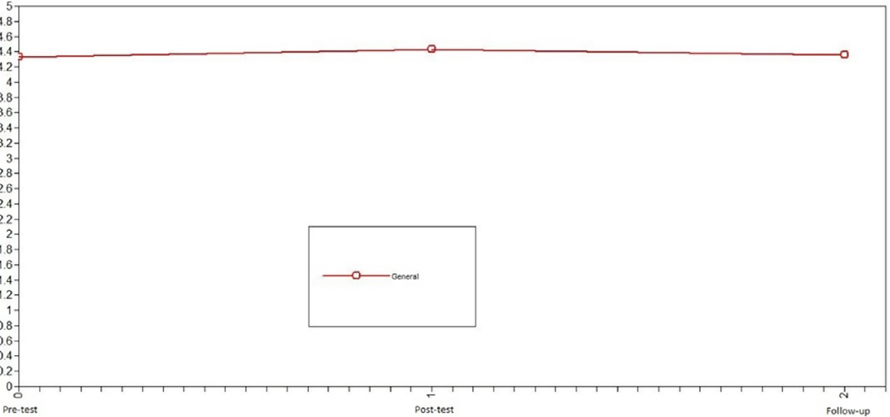
Fig 8. Latent growth curve models of prosocial behavior toward friends of the intervention group. The model that presented the best fit was the nonlinear change model.